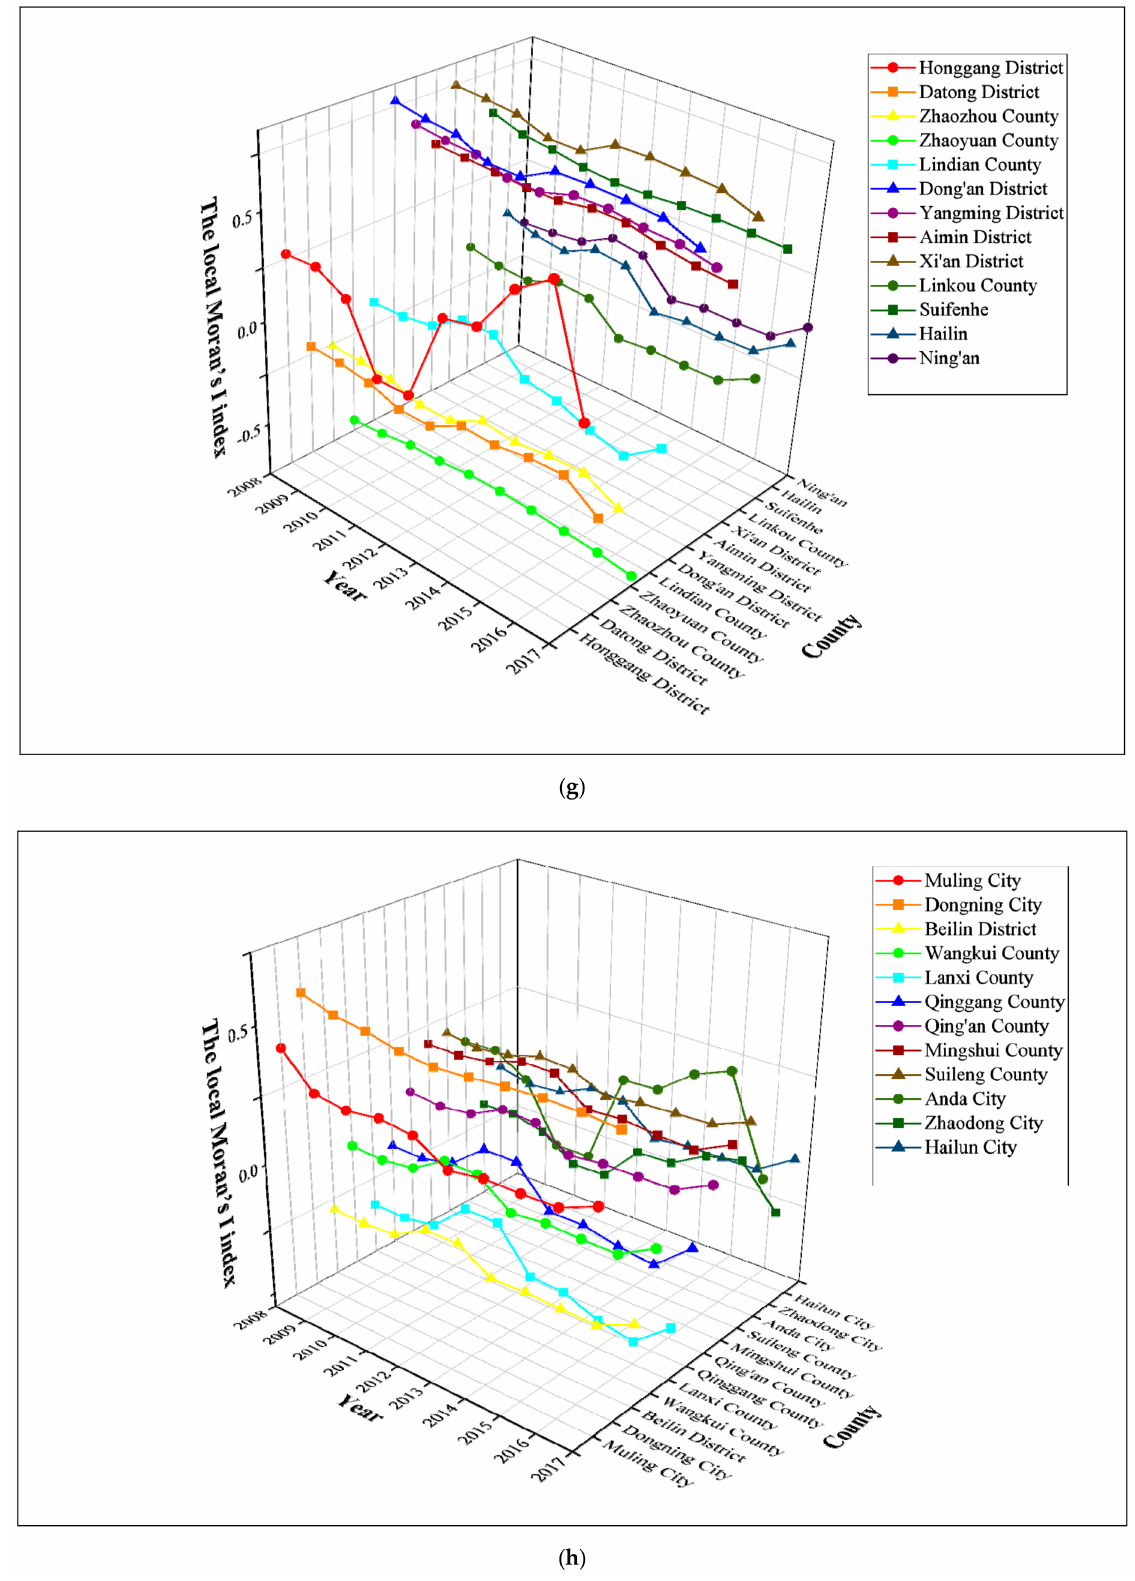
Figure 4. The local Moran’s I index of the Harbin–Changchun urban agglomeration from 2008 to 2017 (Panel ( a – h ) include the 103